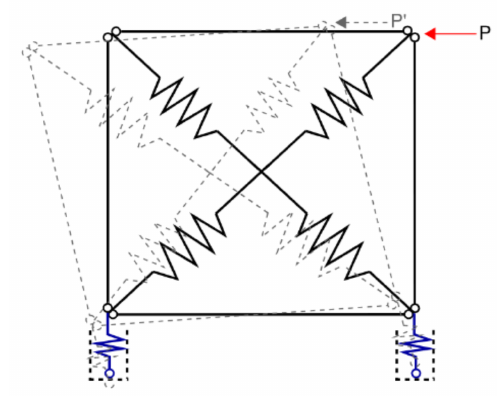
Figure 4. Shearwall segment model (adapted from